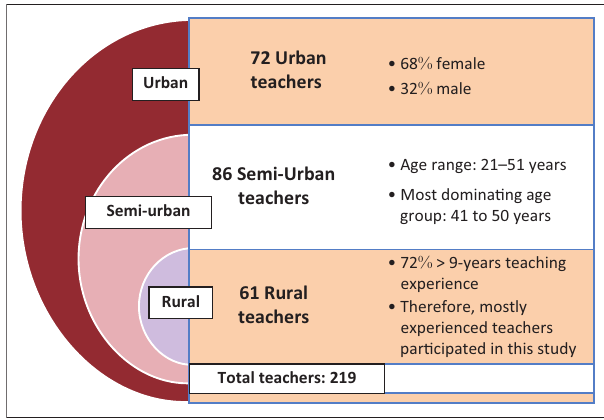
FIGURE 1: Participant